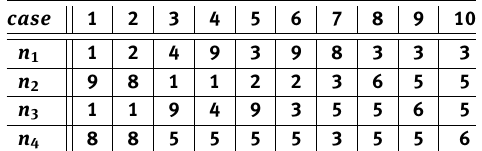
Table 6. n = 38 with two n i in M